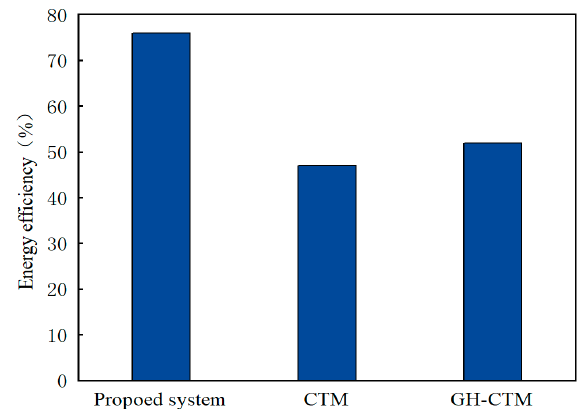
Figure 5. Energy efficiency of the proposed process, CTM, GH-CTM process.